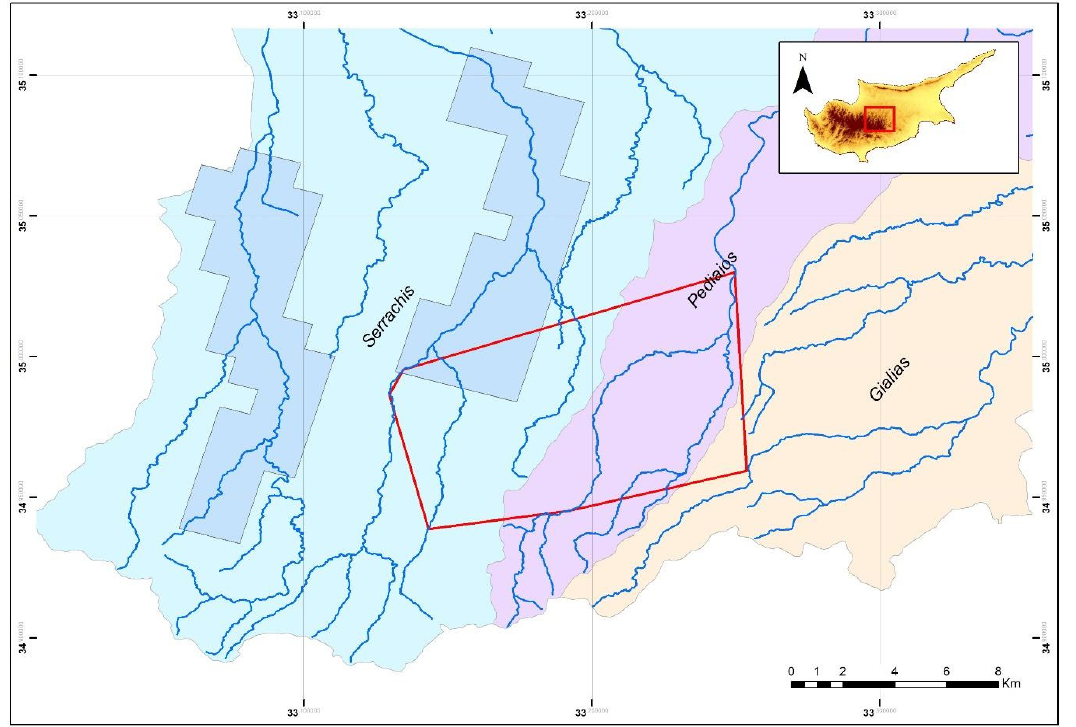
Figure 5. Map of the study site in the Troodos Mountains, indicating the currently known species distribution of N. n. cypriaca (blue polygon), the watersheds of the area (named and coloured: Serrachis—light blue and Pediaios—purple, Gialias—orange), and the minimum convex polygon extracted by the data of this research (red polygon). This is the first time that individuals of the species are found outside the Serrachis watershed that covers their distribution.